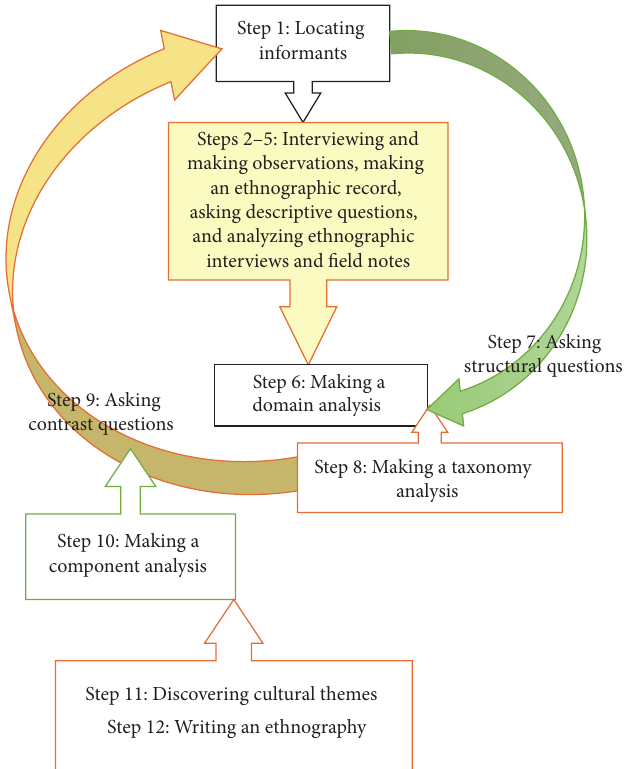
Figure 1: The 12 steps of the research process according to Spradley [17].